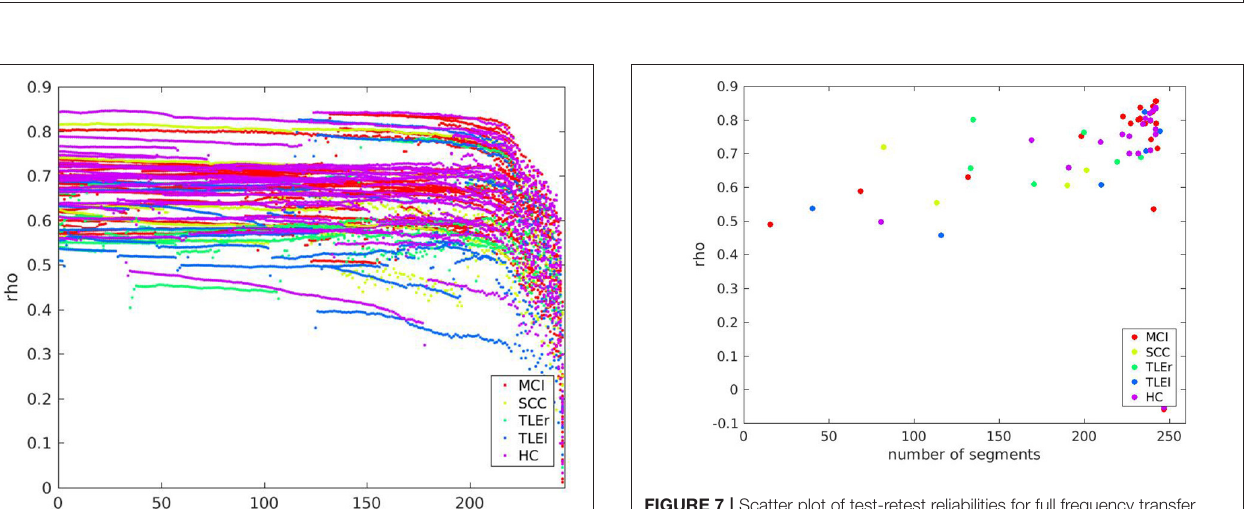
FIGURE 5 | Boxplots of test-retest reliabilities for coherence (A) and full frequency directed transfer function (B) in separated frequency ranges.